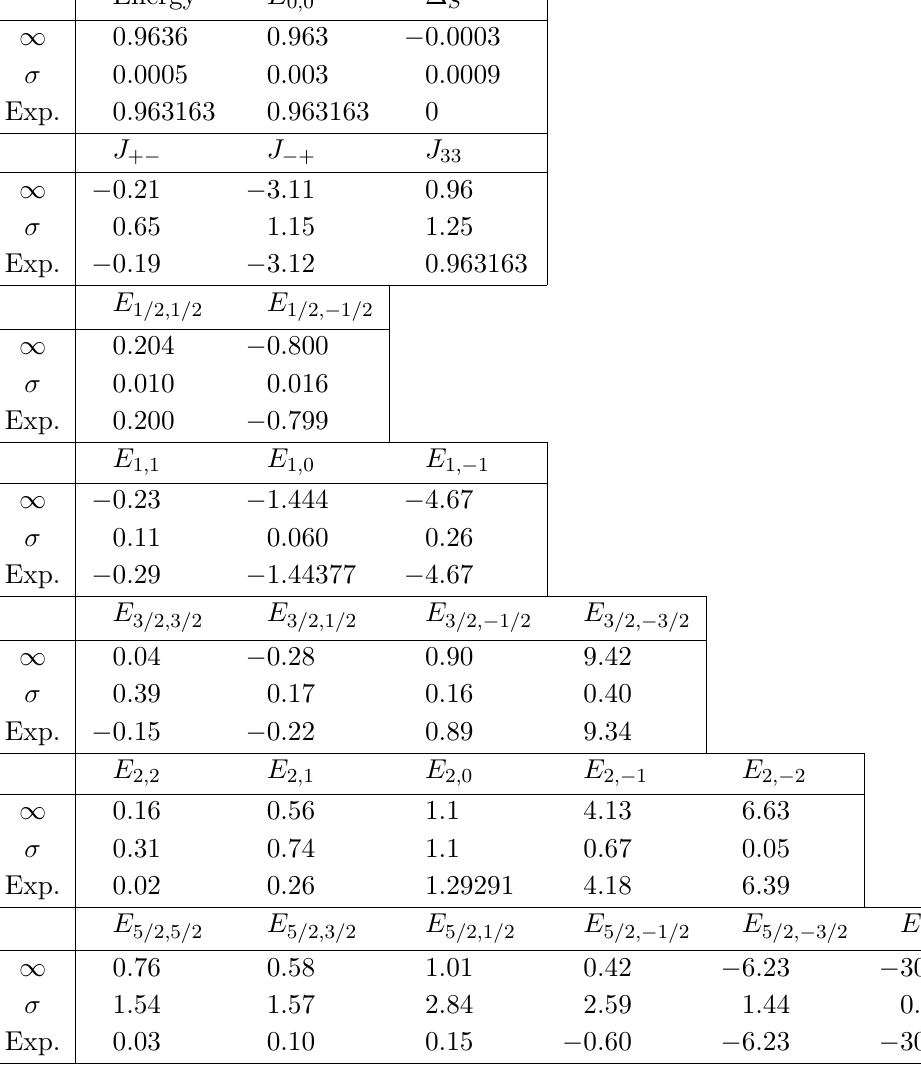
Table 30 . Extrapolations of observables of a solution describing two SL(2, C ) 0-branes with θ 1 = 2 π and ρ = ρ 0 . 50 in the k = 5 model with J = 1 boundary θ 2 = − 2 π 1 2 ≈ k